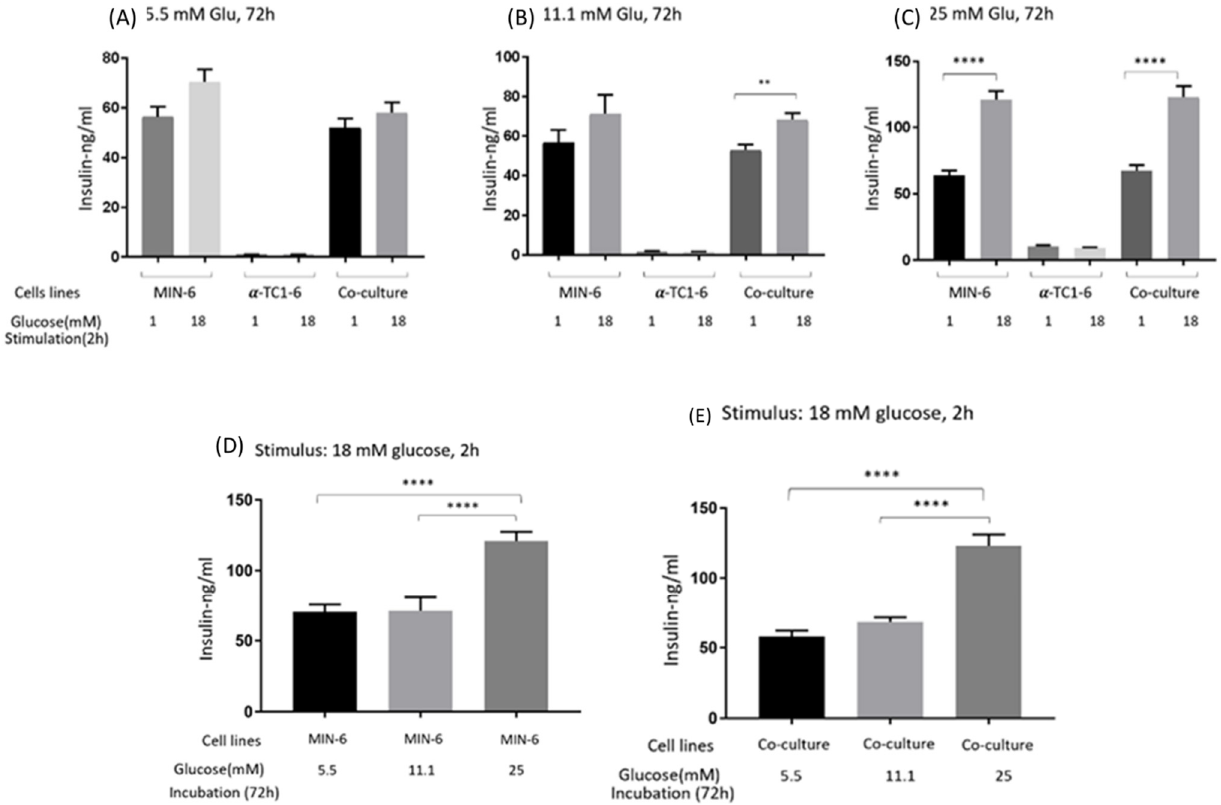
Figure 1. Insulin secretion from mono- or co-cultured MIN-6 and α -TC1-6 cells when stimulated with low (1 mM) or high (18 mM) glucose after 72 h incubation in ( A ) 5.5, ( B ) 11.1, or ( C ) 25 mM glucose, respectively. ( D ) Insulin secretion from MIN-6 cells when stimulated with high glucose after 72 h incubation in 5.5, 11.1, or 25 mM glucose, respectively. ( E ) Insulin secretion from co-cultured cells when stimulated with high glucose after 72 h incubation in 5.5, 11.1, or 25 mM glucose, respectively. Data are presented as the mean ± SEM of 18 samples per condition from three independent experiments. ** p < 0.01, **** p < 0.0001.